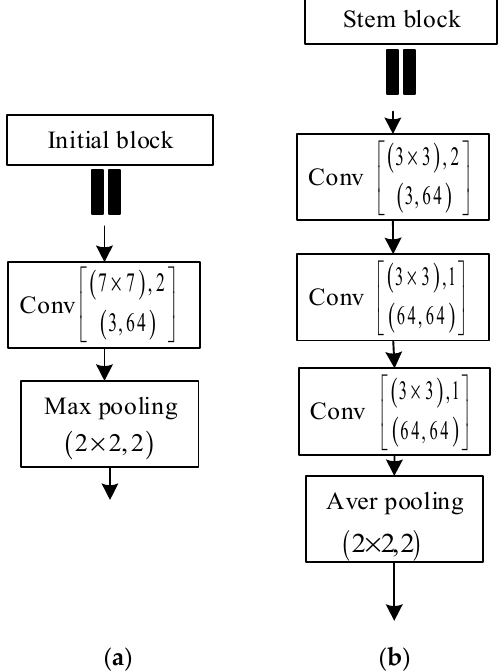
Figure 6. The contrast of initial block and stem block: ( a ) initial block and ( b ) stem block.